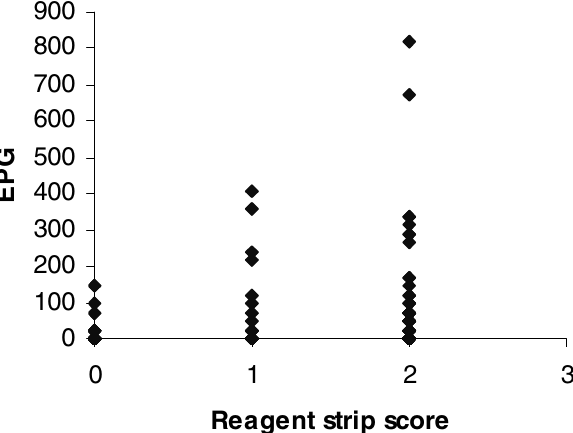
Fig. 1. – Association of reagent strip score with the intensity of S. mansoni